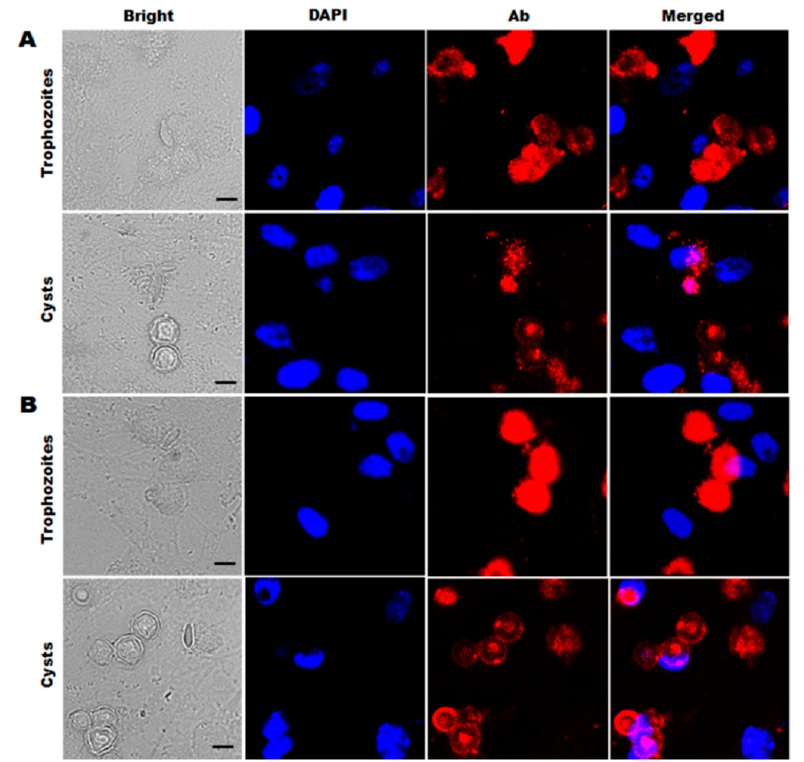
Figure 1. Specific detection of Acanthamoeba spp. by ACAP or PBP antibodies. Human corneal epithelial (HCE) cells were cultured with A. castellanii trophozoites or cysts, F. solani , S. aureus , and P. aeruginosa . The co-cultured cells were stained with DAPI and anti-ACAP antibodies ( A ) or DAPI and anti-PBP antibodies ( B ). Bright-field, DAPI staining (blue), ACAP or PBP antibodies combined with CFL555-conjugated secondary antibody (red), and merged images were acquired at 400 × magnification. Scale bar = 10 µ